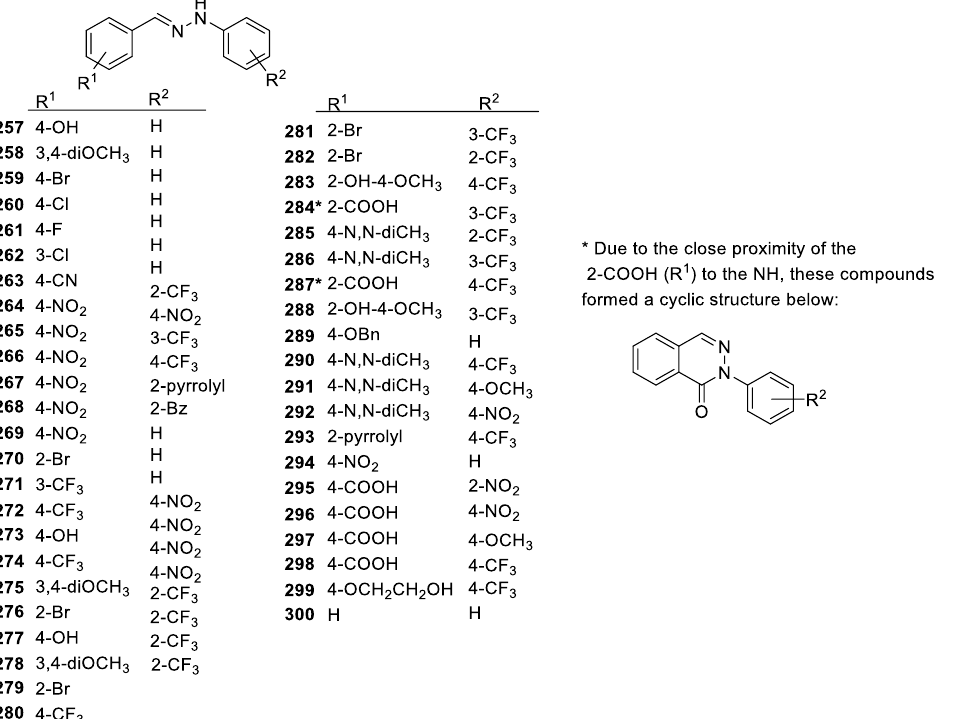
Figure 19. Representative structures of diarylhydrazone antioxidants.